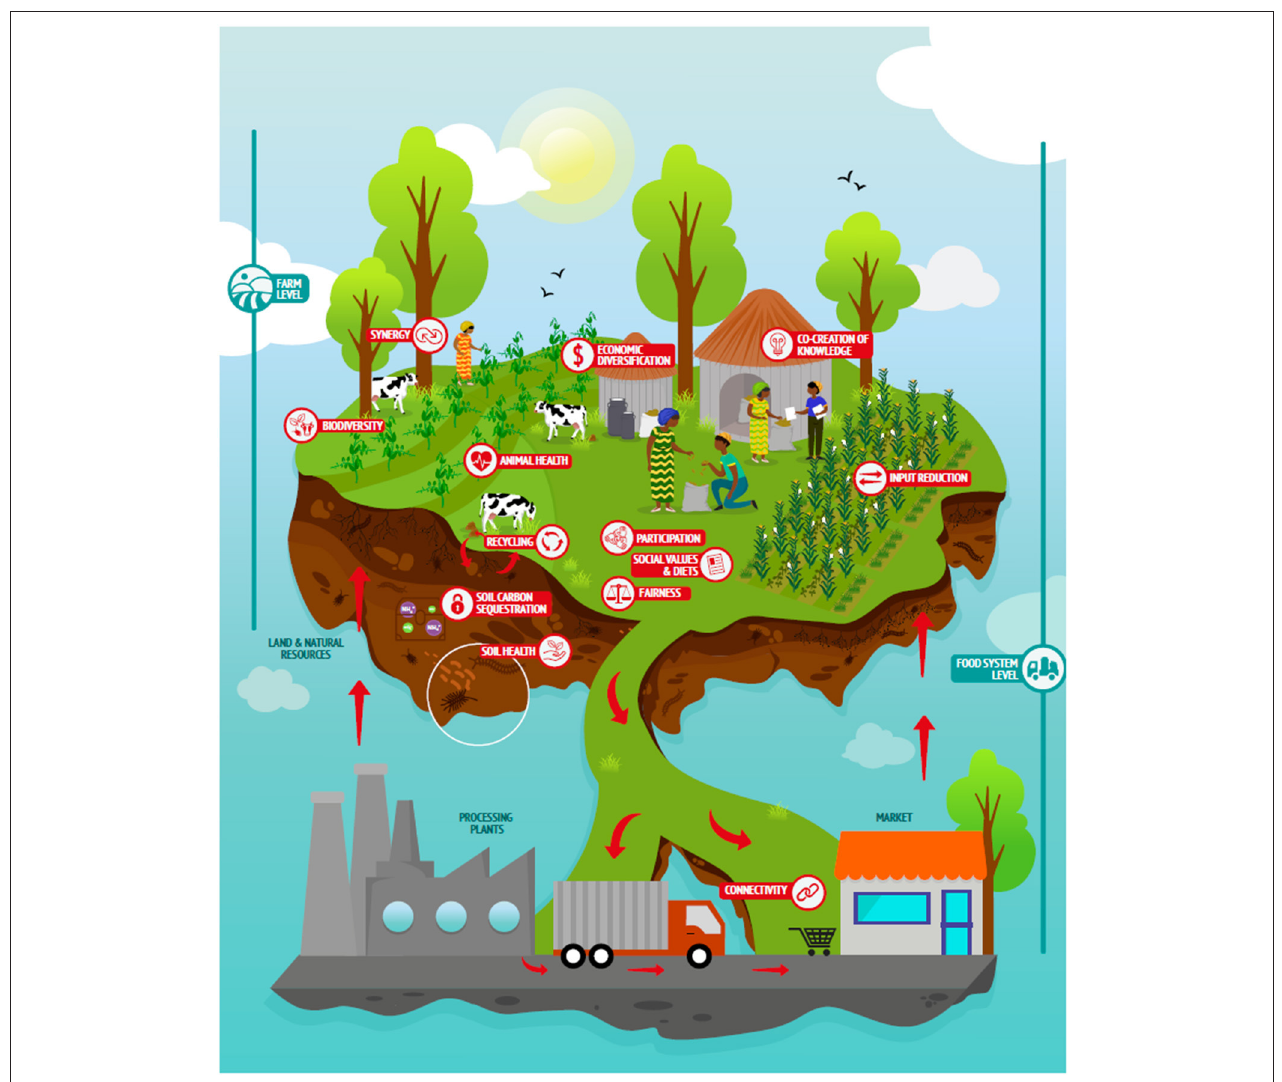
FIGURE 1 | The agroecological principles at work in a forage-based mixed croptree-livestock